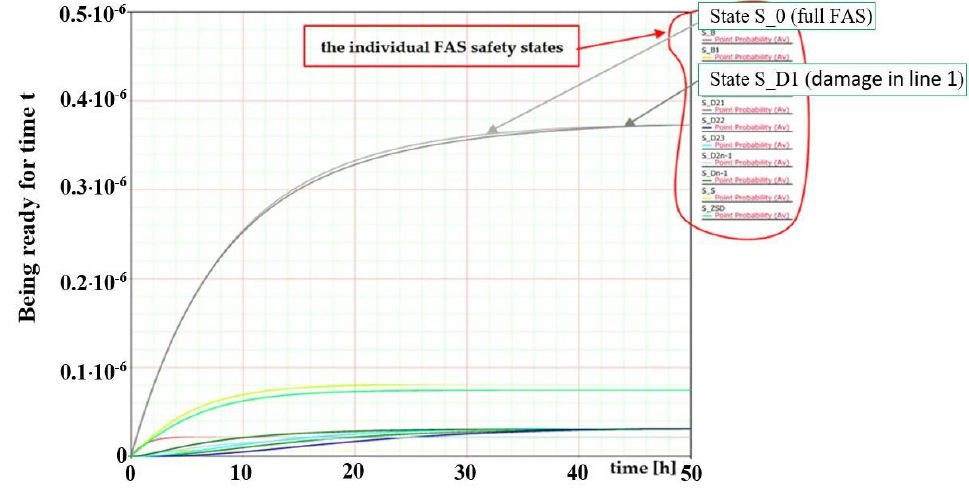
Figure 9. Graphs of availability over time for individual states of an FAS integrated with smoke exhaust and common fire detection [printout from the BlockSim software].